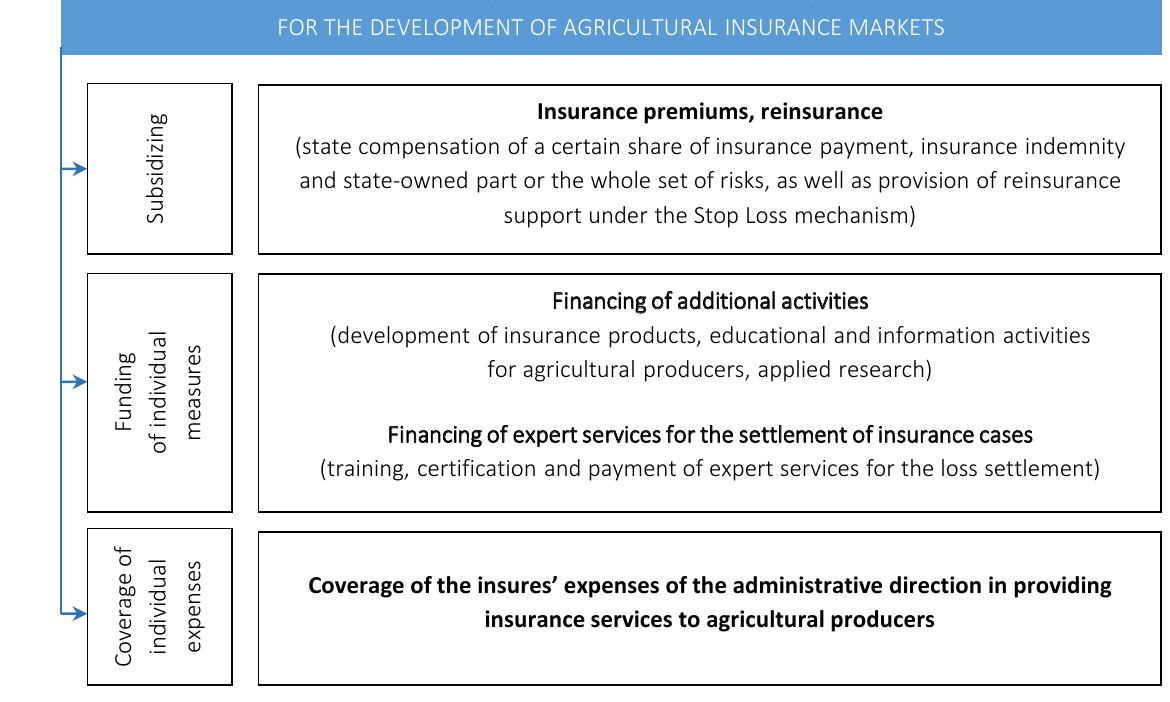
Figure 15. International practice of state support for the development of the insurance market in the agrarian sector of the